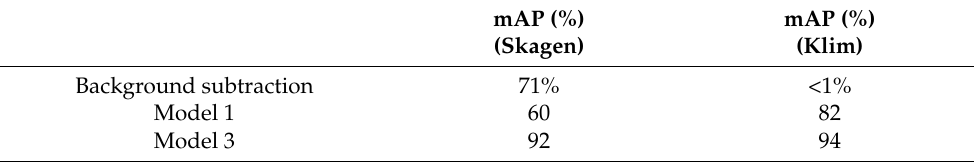
Table 6. Accuracy of the testing set using computer vision and deep